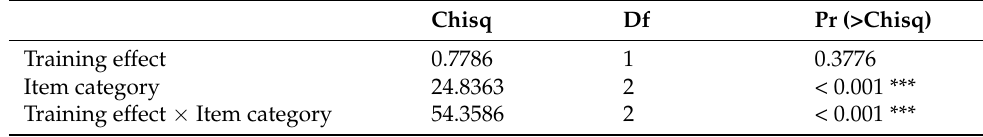
Table 10. Summary of the effects in the experiment (unnatural groups).